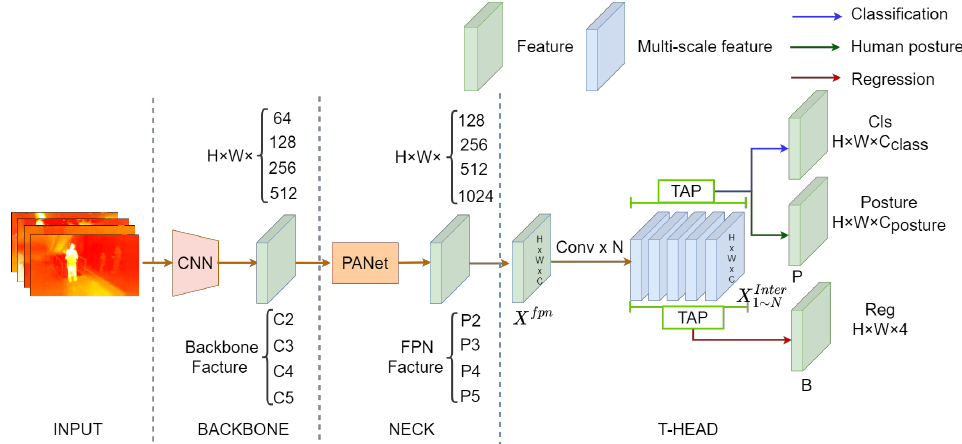
Figure 7. The generalstructure of the IPH-TOOD detector we proposed. The network structure is a car- ryover from TOOD [60] with the difference of an extra head that is utilized to predict human